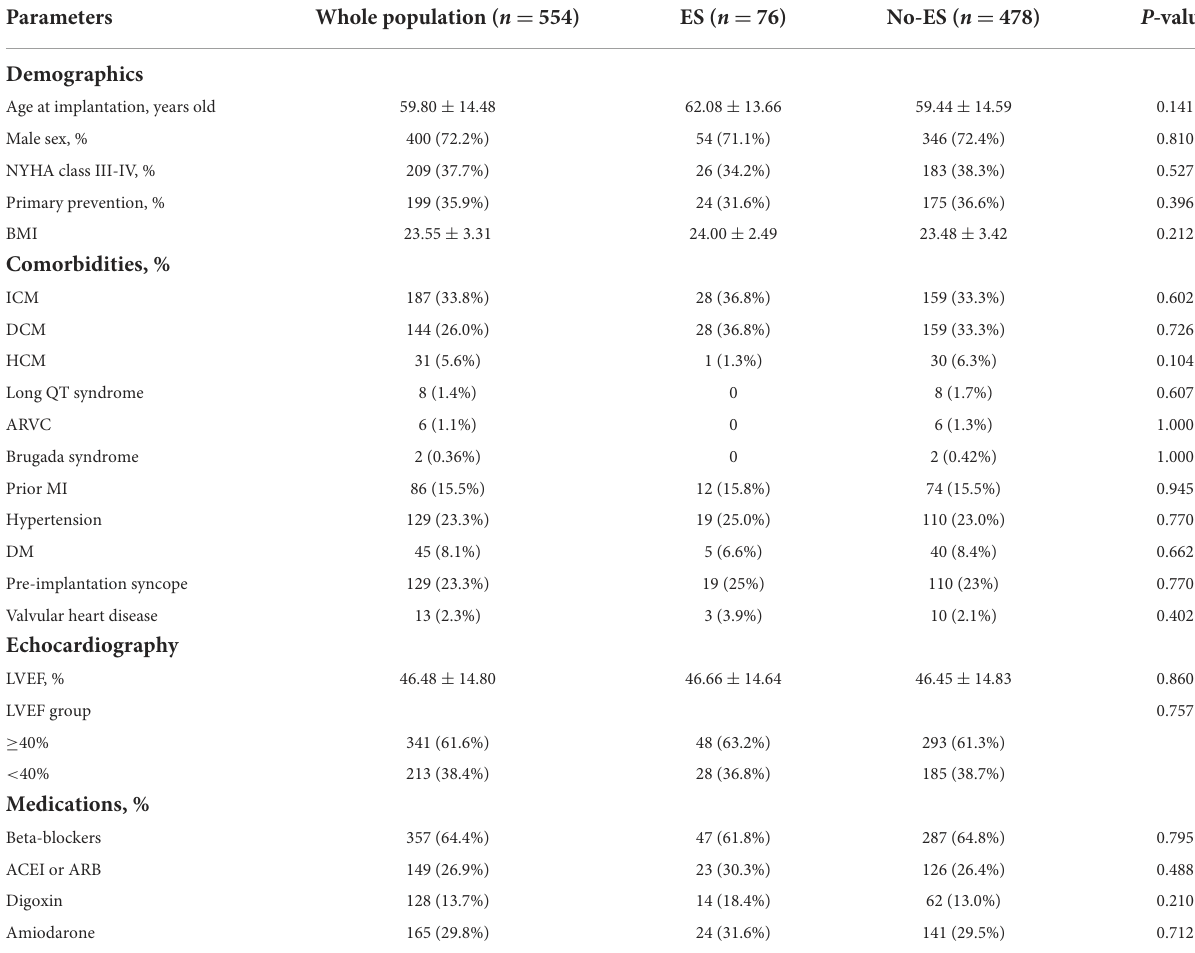
TABLE 1 Baseline characteristics of patients stratified by electrical storm (ES).